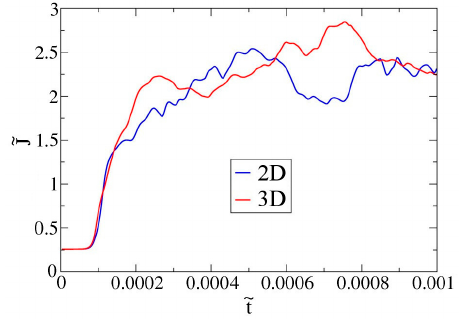
Water 2019 , 11 , x FOR PEER REVIEW Figure 10. Baseline case, (cid:101) V = 120. Area-averaged current density for the smooth membrane. The dimensionless current density, 𝐽(cid:4634) , obtained from the 2-D simulations was averaged for 0.02 (cid:3407) 𝑡̃ (cid:3407) 0.1 (Figure 11). Similar to experimental J - V curves (e.g., [9,23,24]), three distinct regimes